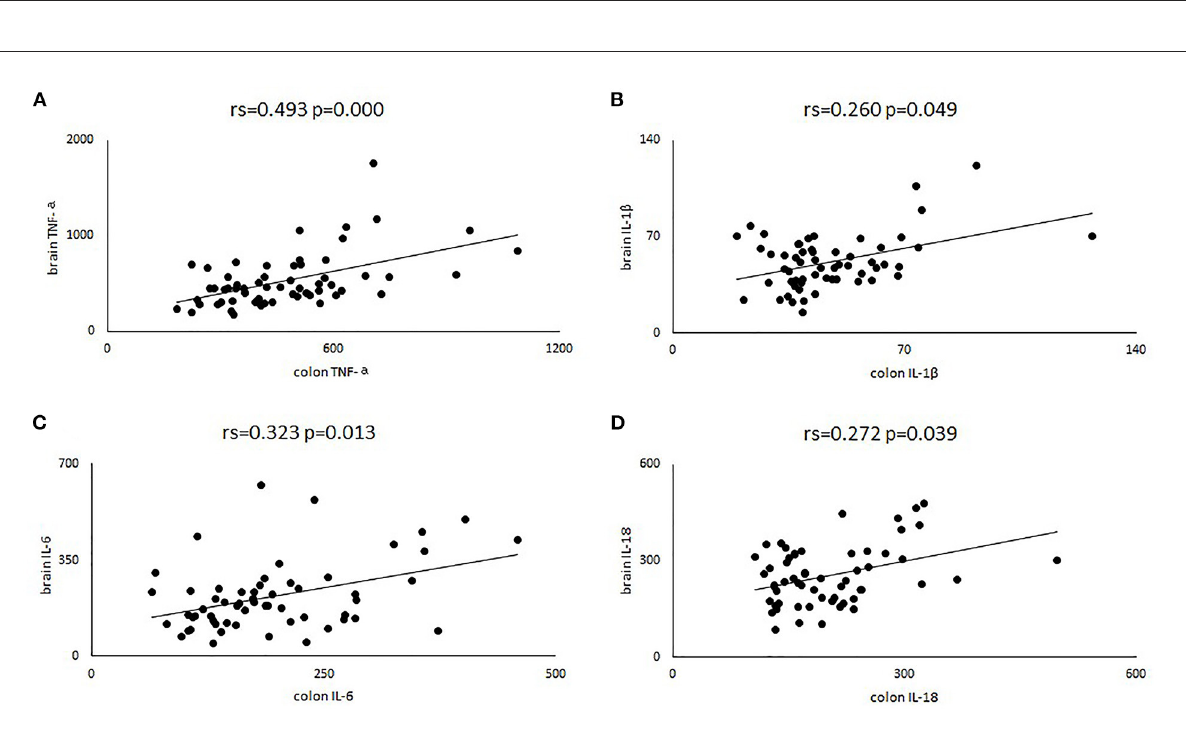
FIGURE6 Four scatter plots were used to describe the correlation of TNF- α (A) , IL-6 (B) , IL-1 β (C) and IL-18 (D) in brain and colon. Rs, represent the spearman correlation